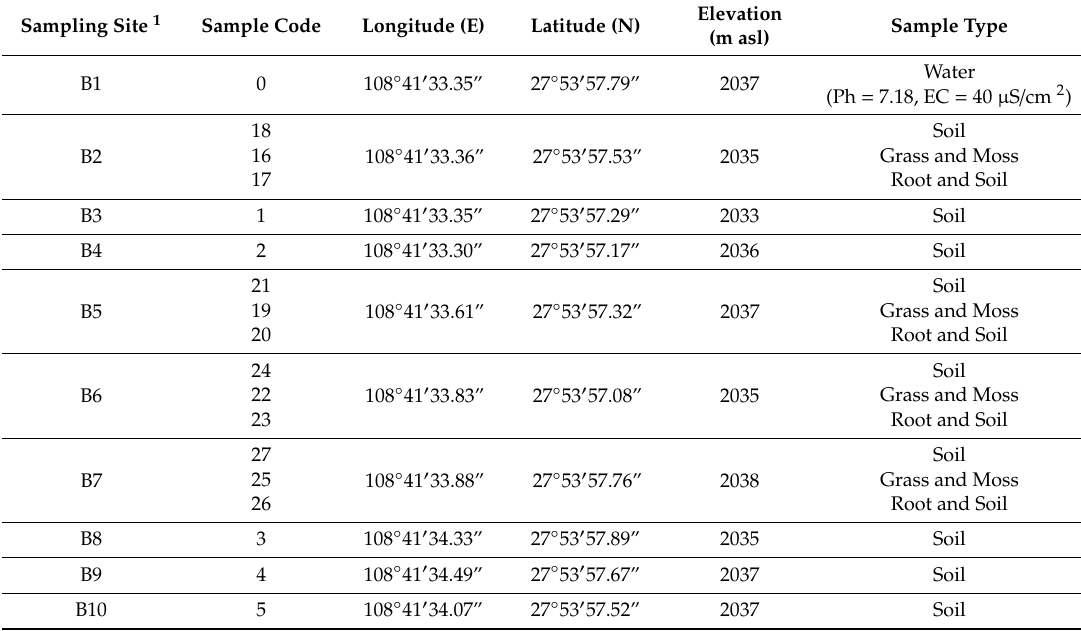
Table 1. The details of sampling sites and samples from the Jiulongchi wetland of Fanjing